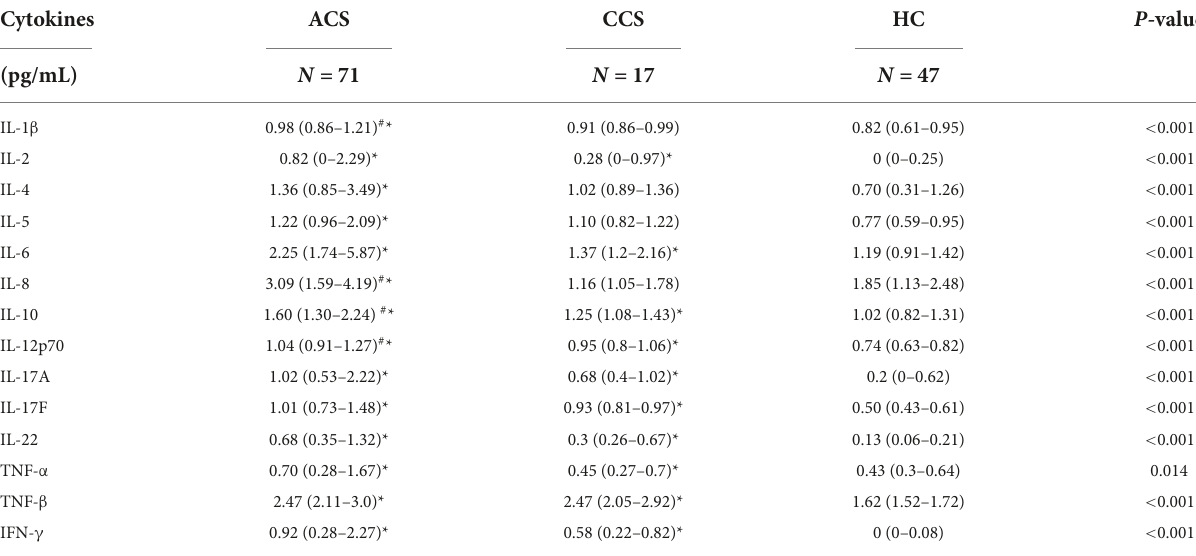
TABLE 3 The plasma levels of inflammatory cytokines in 88